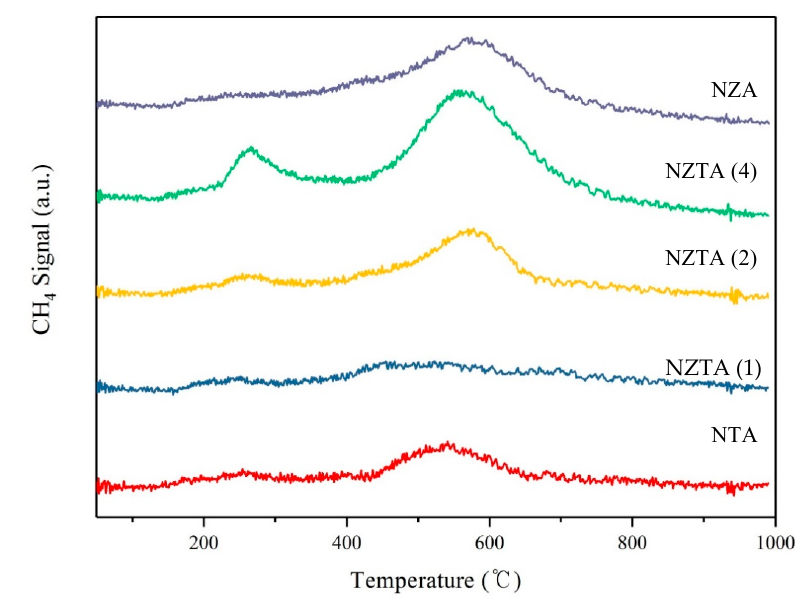
Figure 8. The temperature-programmed hydrogenation (TPH) profiles of the spend catalysts for 5 h. Catalysts 2020 , 10 , x FOR PEER REVIEW